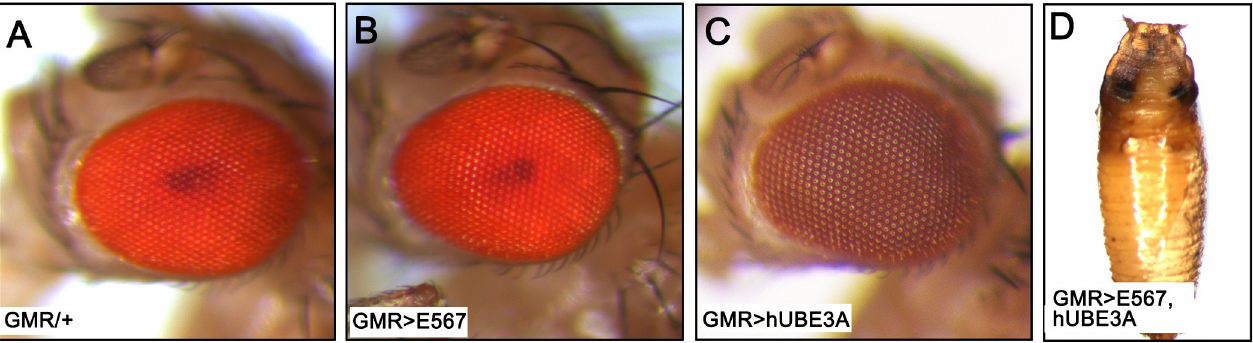
Fig 1. Expression of HPV16 E5, E6, and E7 oncogenes leads to mortality in a human UBE3A-dependent manner. Transgenes were expressed using the GMR-Gal4 in the eye discs (A-D) . The wild type (A) and expression of HPV16 E5, E6, E7 alone (B) or hUBE3A (C) showed no phenotypic defects in the adult fly eye. Flies co-expressing E5, E6, E7 and hUBE3A (D) did not develop beyond the pupal stage.